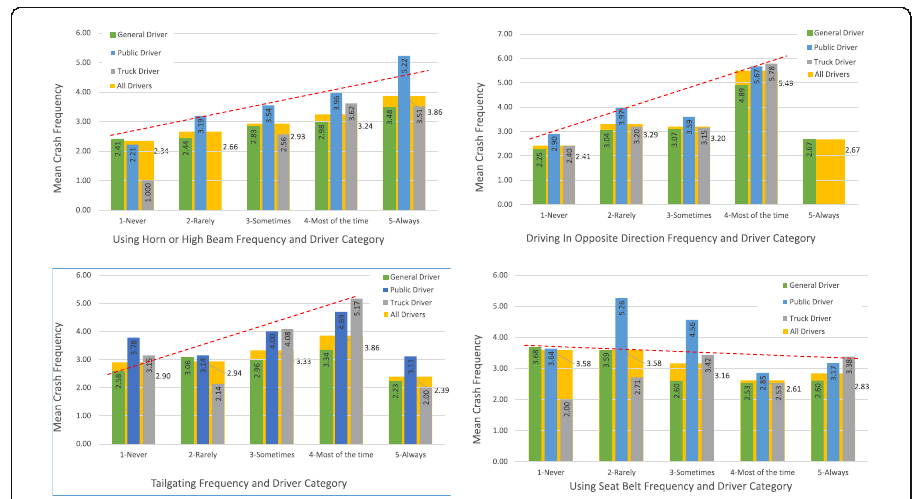
Fig. 4 Data trend for the average mean crash frequency for each